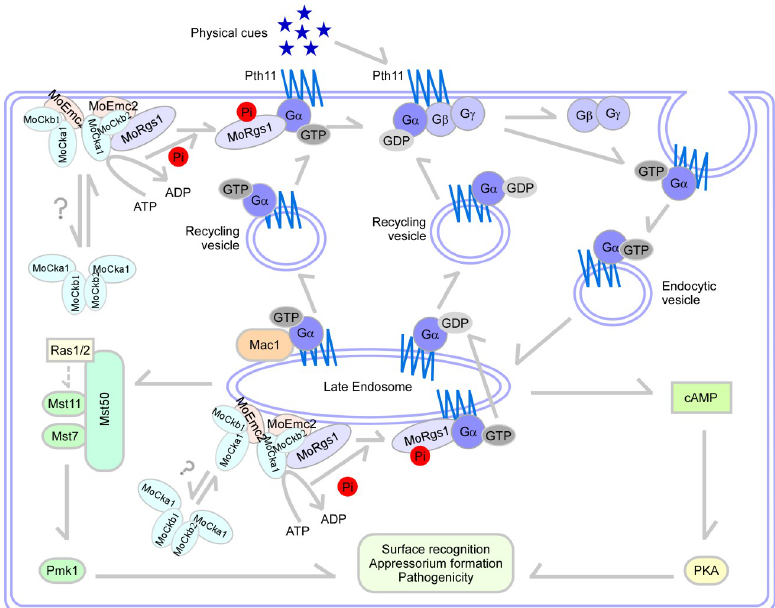
Fig 6. A proposed model of MoRgs1-MoEmc2 interaction in G-proteins signaling. In the process of recognizing hydrophobic cues at the surface of host plant rice, the ER membrane protein complex subunit MoEmc2 plays a critical role in modulating G α function and cAMP signaling of M . oryzae . MoRgs1 is phosphorylated by MoCk2, then functions as a GTPase-activating protein (GAP) to negatively regulate G-protein signaling. At the same time, MoEmc2 regulates the subcellular localization of MoCk2 nearby the inner PM, which is critical for the MoRgs-MoCk2 interaction. The entire process is required for proper G-protein/cAMP signaling involved in appressorium formation and pathogenicity of M . oryzae